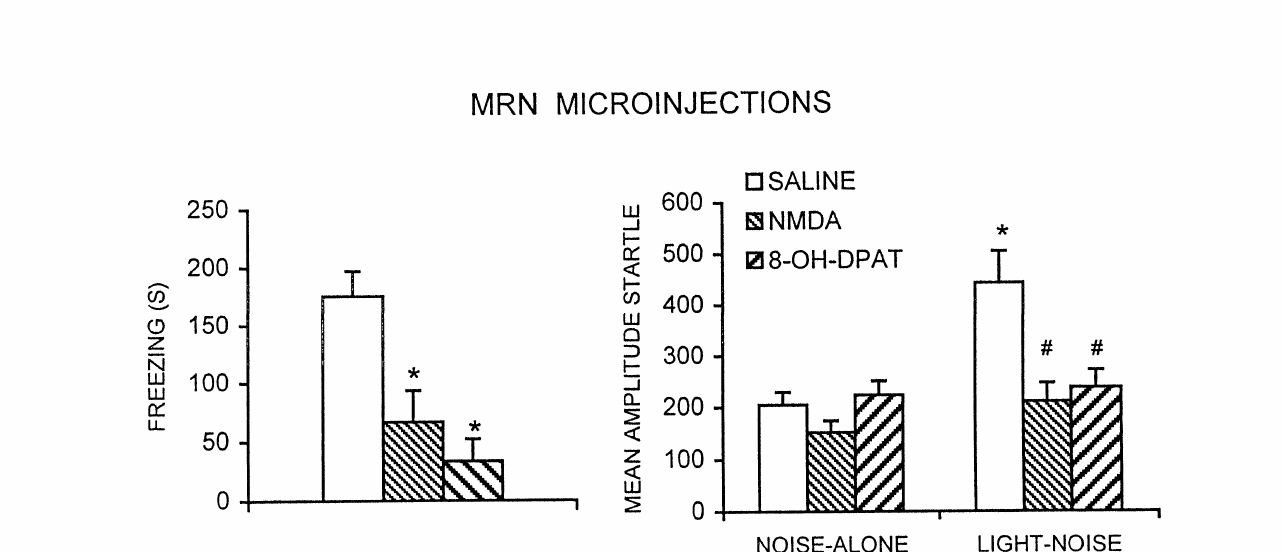
Fig. 5: Left: Effects of pre-training injections of NMDA and 8-OH-DPAT into the MRN on time (sec) of freezing in rats placed into the chamber where they had received footshock. Control animals received saline microinjections. Mean + S.E.M. of 10 animals in control and treated groups. * p<0.01, Newman-Keuls test. Right: Effects of pre-training injections of NMDA and 8-OH-DPAT into the MRN on the mean amplitude startle response as compared to control animals (saline). * Different from noise-alone condition. # Different from the corresponding control condition (p<0.05, Newman-Keuls test), n 10 in both